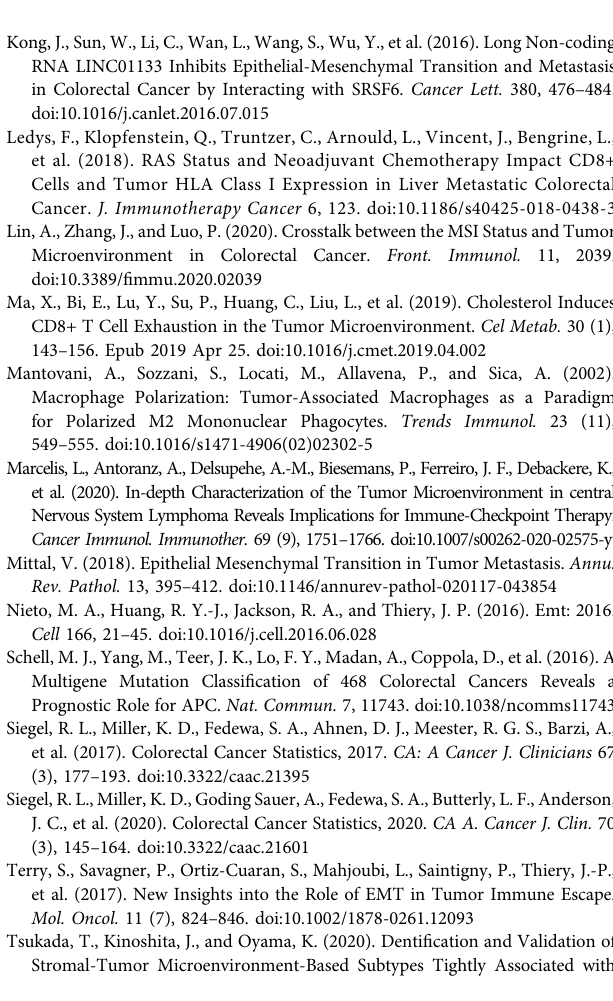
Supplementary Figure 1 | (A – C) The high mutation rate of USH2A, NEB genes in the high-risk group related to the decreased in fi ltration of CD4 + and CD8 + T lymphocytes, while increased in fi ltration of Treg cells, except CSMD3. Supplementary Figure 2 | (A – C) The high mutation rate of DNAH5, FAT3, and FBXW7 genes in the low-risk group related to the increased in fi ltration of CD4 + and CD8 + T lymphocytes, while decreased in fi ltration of Treg cells. Supplementary Figure 3 | (A, B) The higher mutation rateof APC and TP53 genes in the high-risk group led to the decreased in fi ltration of CD4 + and CD8 + T